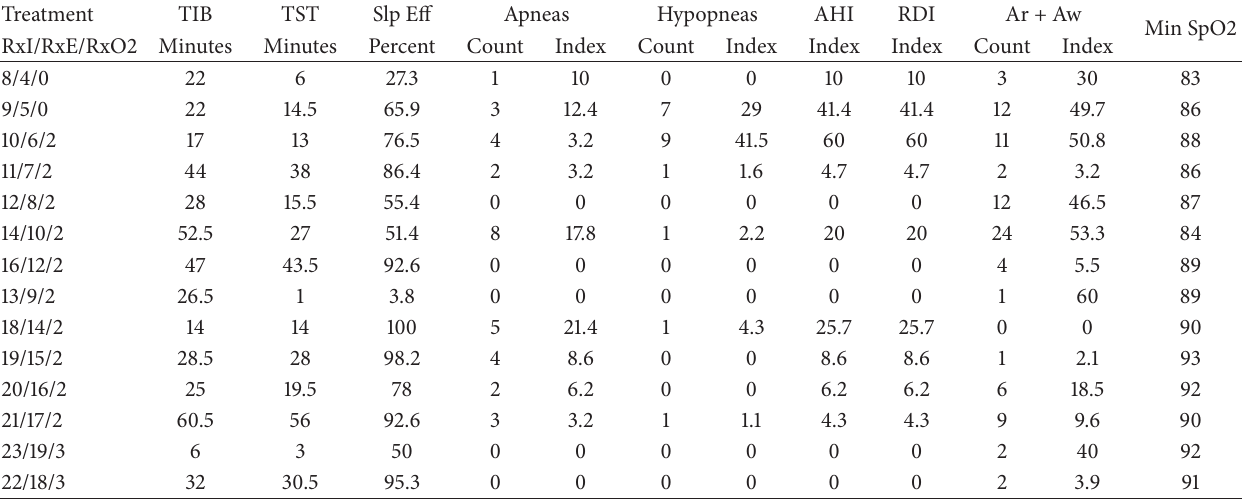
Table 1: Treatment parameters and results.